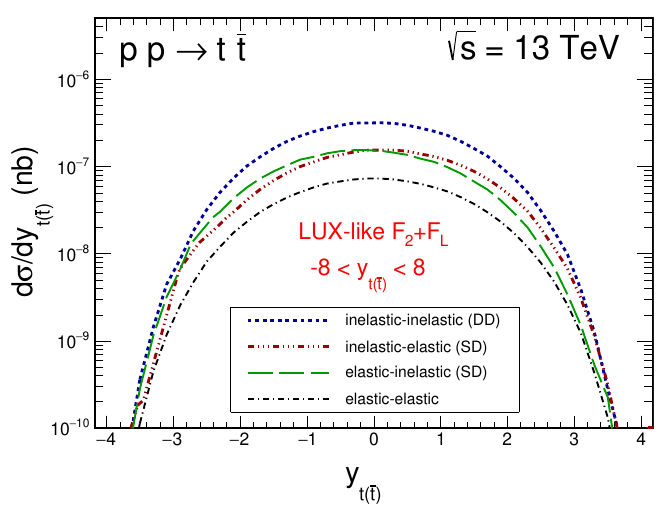
Figure 2 . Rapidity distribution of t or (cid:22) t for di(cid:11)erent components de(cid:12)ned in the (cid:12)gure.